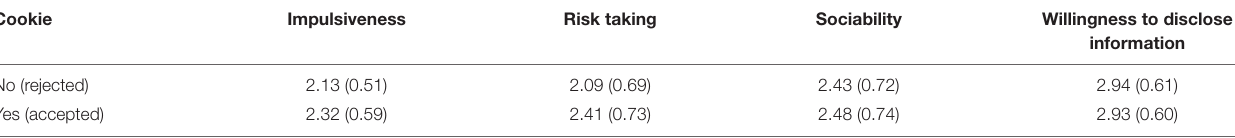
TABLE 2 | Means and standard deviations for personality differences by cookie acceptance.